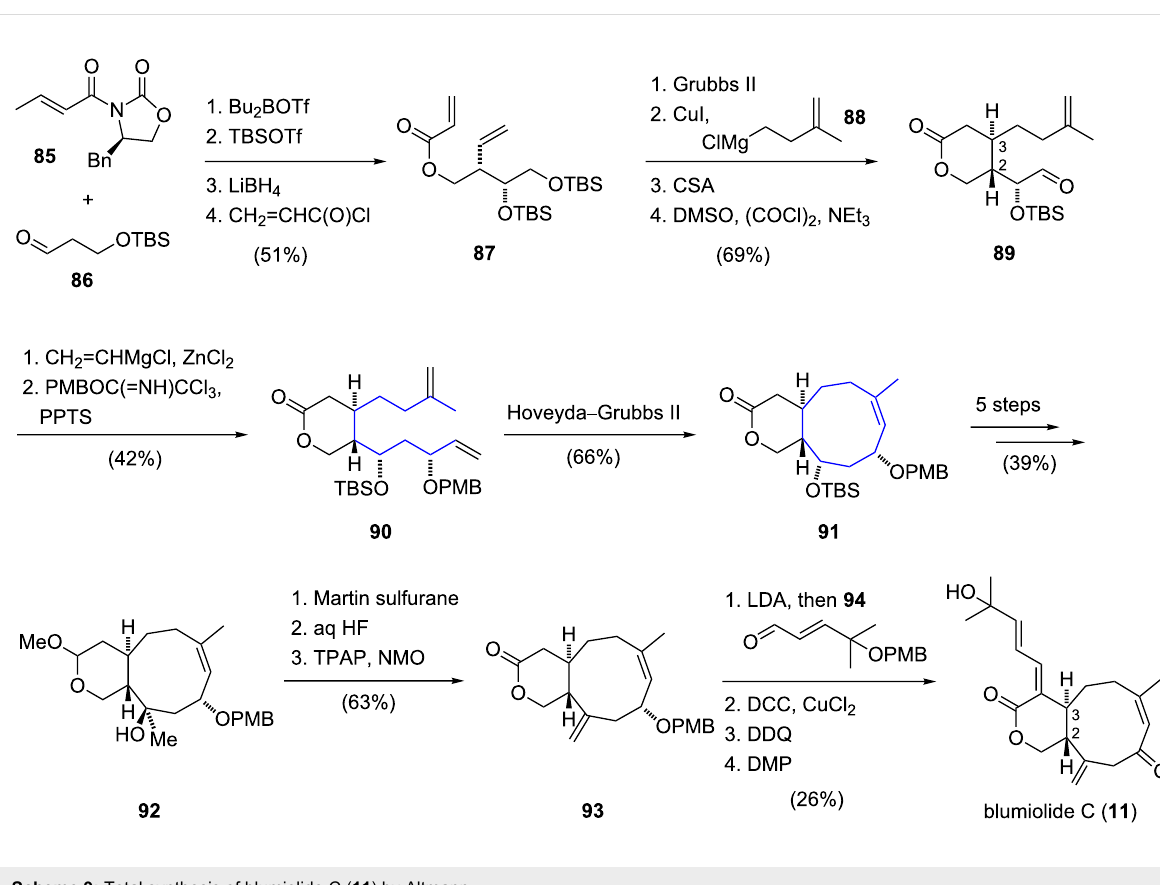
Scheme 9: Total synthesis of blumiolide C ( 11 ) by